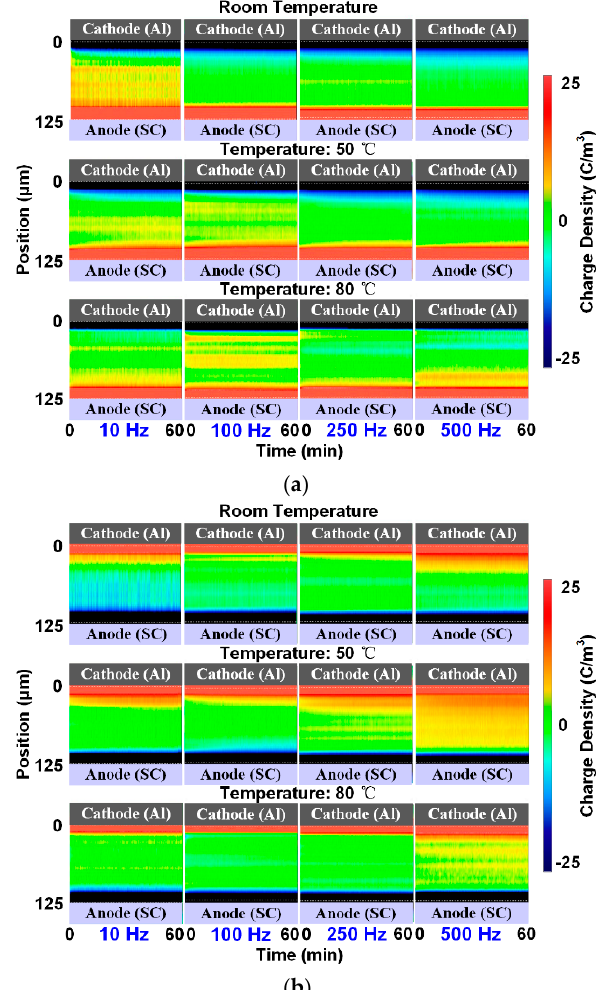
Figure 9. Charge results under half-wave sine voltages at different temperatures: ( a ) positive voltages, ( b ) negative voltages.